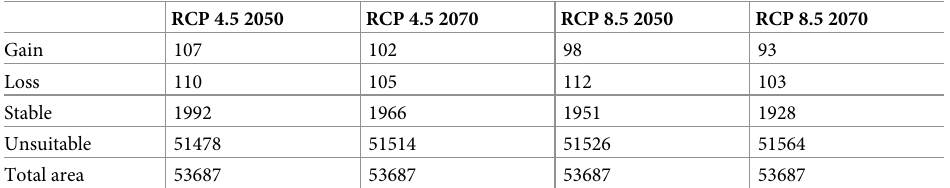
Table 3. Habitat transformation (km 2 ) as predicted by comparison with present distribution using RCP 4.5–8.5 (2050 and